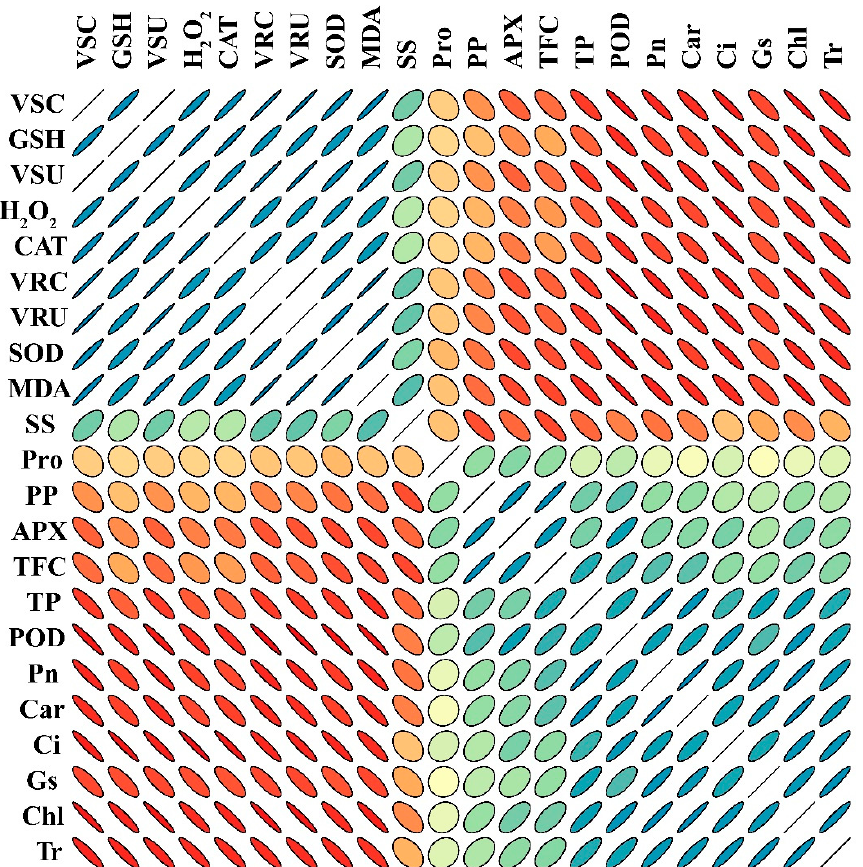
Figure 10. Pearson’s correlation analysis (PCA) ( p < 0.05) was calculated among different traits of V-treated sweet potato seedling. VSC (V shoot concentration), GSH (reduced glutathione), VSU (V shoot uptake), H 2 O 2 (hydrogen peroxide), CAT (catalase), VRC (V root concentration), VRU (V root uptake in root), SOD (superoxide dismutase), MDA (malondialdehyde), SS (soluble sugars), Pro (proline), PP (total polyphenols), APX (ascorbate peroxidase), TF (total flavonoids), TP (total proteins), POD (peroxidase), Pn (photosynthetic assimilation), Car (carotenoids), Ci (Intercellular CO 2 ), Gs (stomatal conductance), Chl (total chlorophyll), and Tr (transpiration rate). Measured determinants and strength correlation matrix. The color code for Pearson correlation coefficients (r), with r = 2, r = 0, and r = − 2 denoting red, orange, green, and gray, respectively. A stronger association is denoted by better anisotropy, and the slope of the corresponding line or ellipse represents the trend of that association (positive or negative). Additionally, the ellipses’ direction and anisotropy indicate the slope and strength of the relationship. According to the first principal component order, variables were arranged.